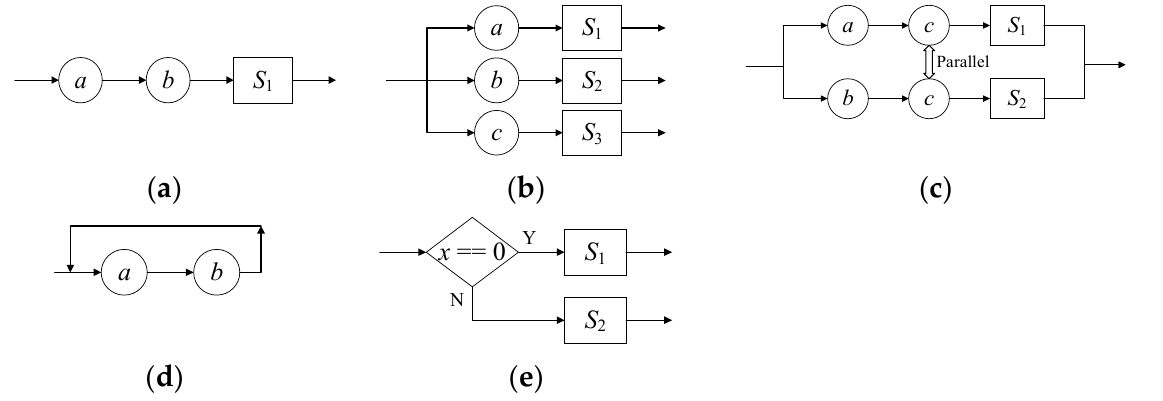
Figure 6. Structural diagram: ( a ) sequential structure; ( b ) selective structure; ( c ) parallel structure; ( d ) iterative structure; ( e ) conditional control structure.